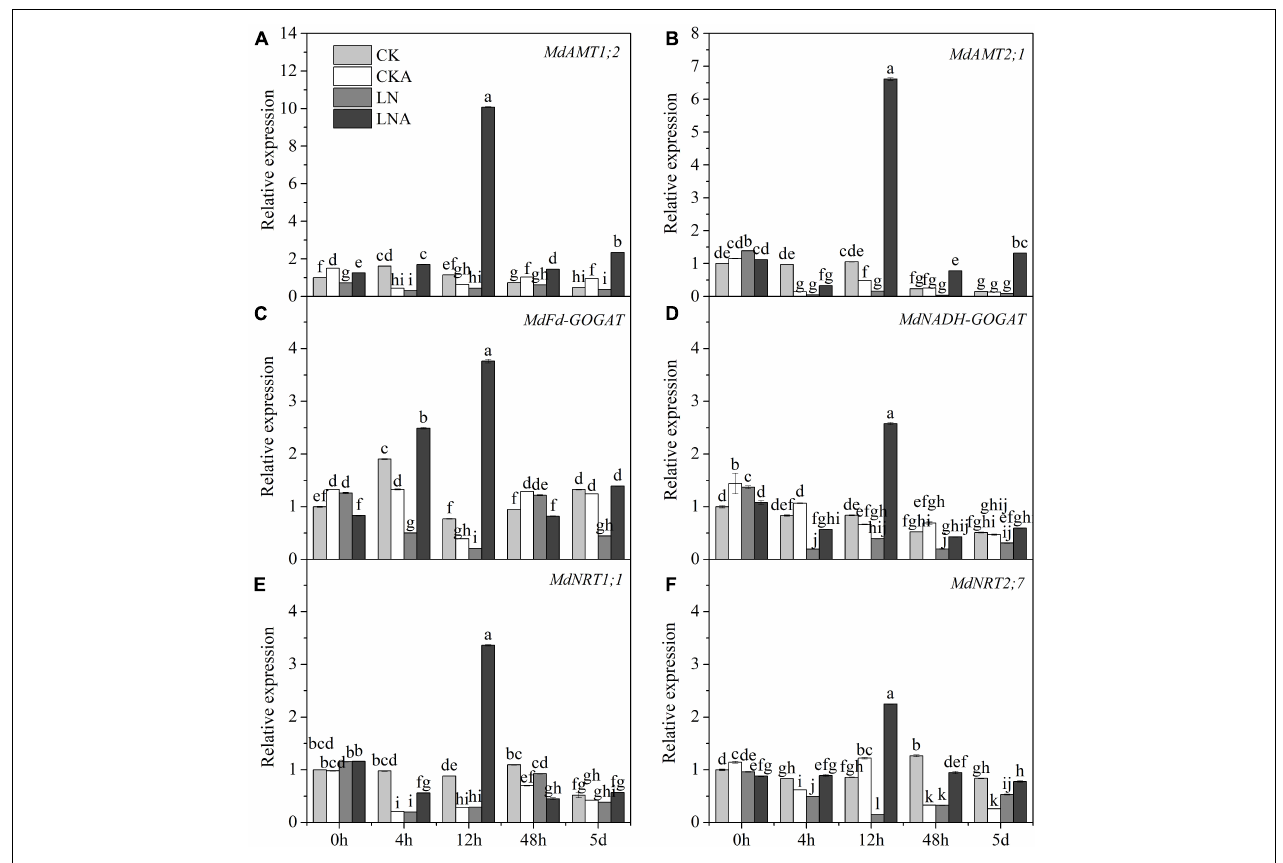
FIGURE 5 | The expression level of N metabolism enzymes. MdAMT1;2 (A) , MdAMT 2;1 (B) , MdFd-GOGAT (C) , and MdNADH-GOGAT (D) , MdNRT1;1 (E) and MdNRT2;7 (F) in CK, CKA, LN, and LNA after treatment. The data are shown up to the fifth day, as no significant responses of the genes were observed after 5 days. Values are means of three replicates ± SD. Values not represented by the same letter are significantly different according to Tukey’s multiple-range test ( P < 0.05).